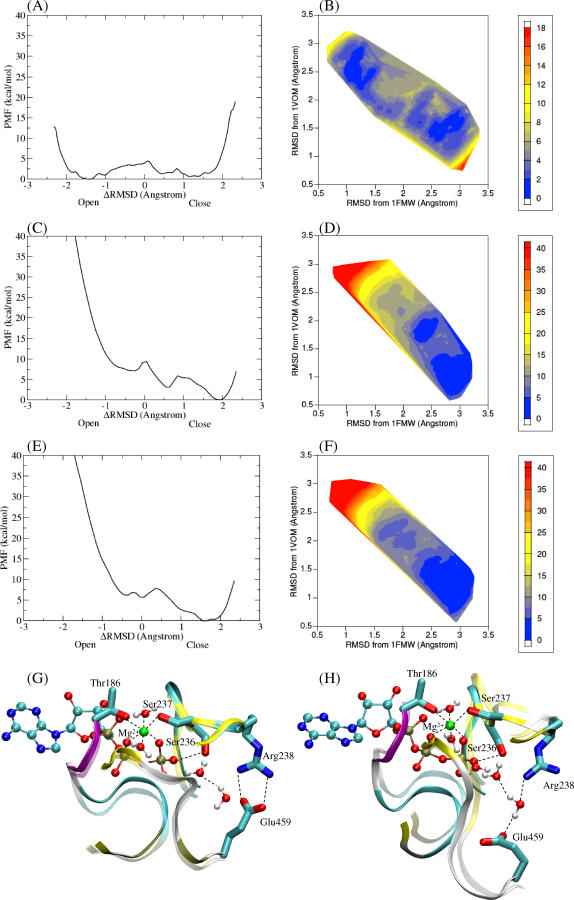
PMF Calculations for the Open/Close of the Active Site with Different Converter OrientationsThe reaction coordinate for 1-D PMFs is ΔRMSD relative to the open and closed active-site configurations; those for 2-D PMFs are RMSDs relative to the open and closed active-site configurations.(A,B) PMFs (in kcal/mol) for the 1FMW:ATP state.(C,D) PMFs (in kcal/mol) for the 1VOM:ATP state.(E,F) PMFs (in kcal/mol) for the 1VOM:ADP·Pi state.(G) Superimposition of the final structure from the 1FMW:ATP simulation at ΔDmin = 2.2 Å (opaque) and the closed reference structure (transparent).(H) Superimposition of the final structure from the 1VOM:ATP simulation at ΔDmin = 2.2Å (opaque) and the open reference structure (transparent).